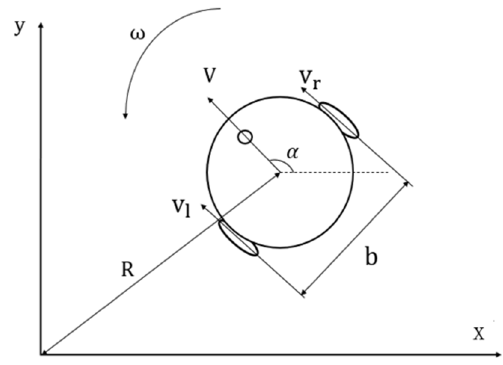
Figure 1. Motion Figure 1. Motion model.